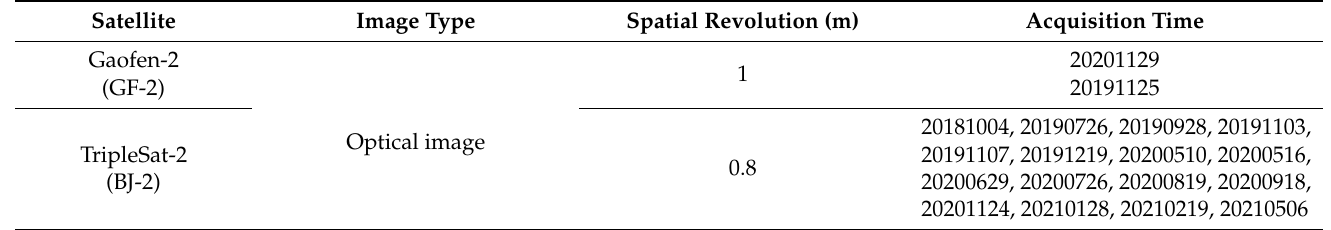
Figure 2. Framework of active landslide detection and deformation analysis. Table 2. Basic parameters of optical